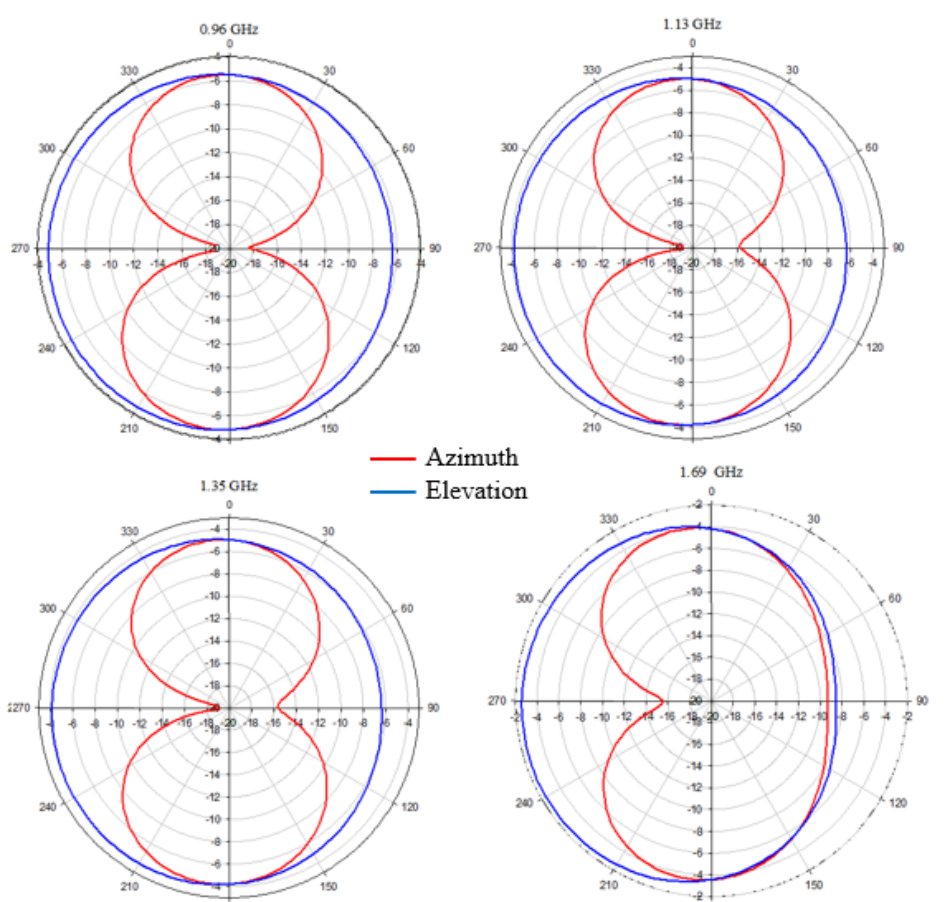
Figure 11. Measured radiation pattern of